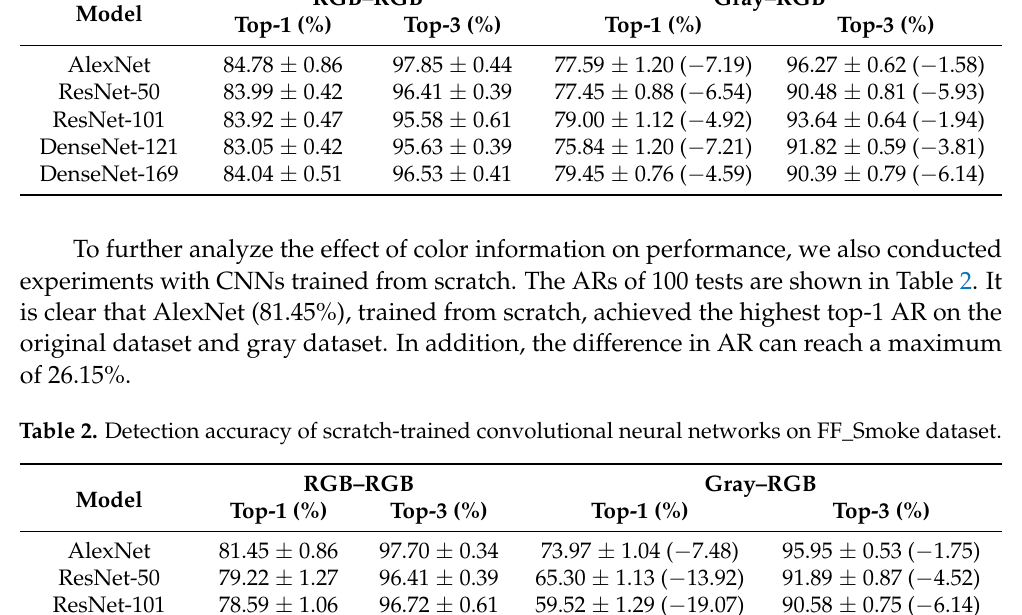
Table 1. Detection accuracy of pre-trained convolutional neural networks on FF_Smoke dataset. Model